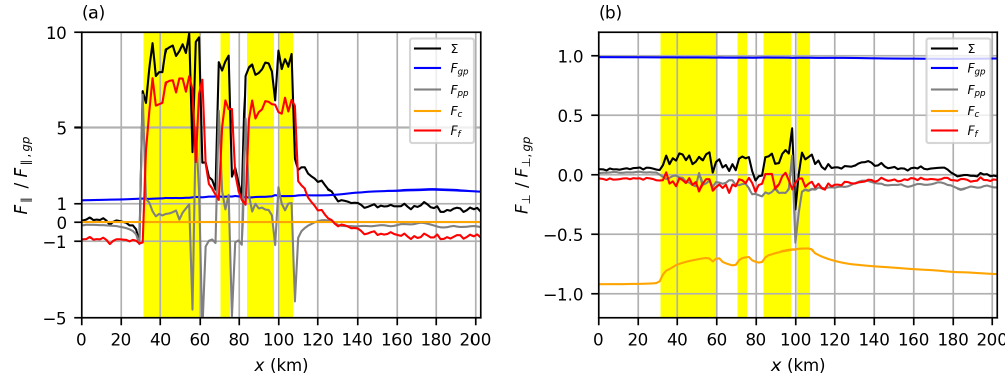
Figure 5. Streamwise and crosswise force components F (cid:107) (a) and F ⊥ (b) along a line at y = 120km and z = 150m for the case NBL- 700-7D. Shown are the geostrophic pressure gradient force ( F gp ), the perturbation pressure gradient force ( F pp ), the Coriolis force ( F c ), the frictional force ( F f , momentum flux divergence) and the sum of all forces ( (cid:54) ). The forces are normalized by the respective geostrophic pressure gradient force component at the inflow and are horizontally averaged over one turbine spacing along x and y . The position of the wind farms is marked by yellow areas.